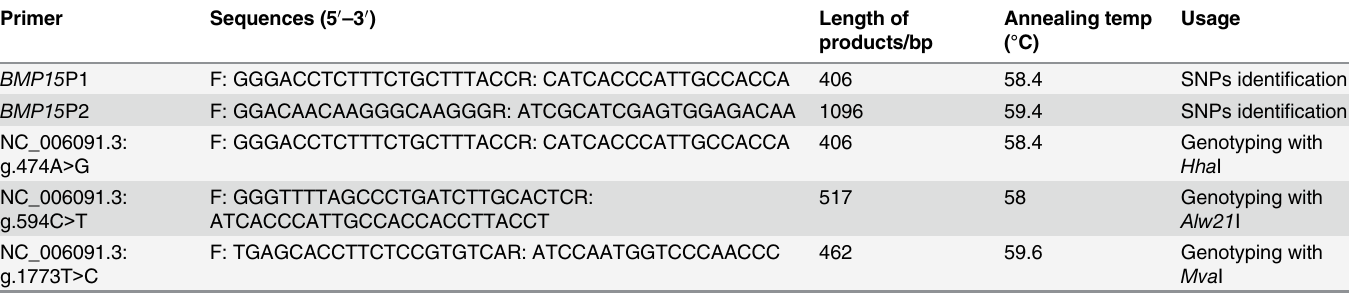
Table 1. Primer parameters for SNPs identification and genotyping of BMP15